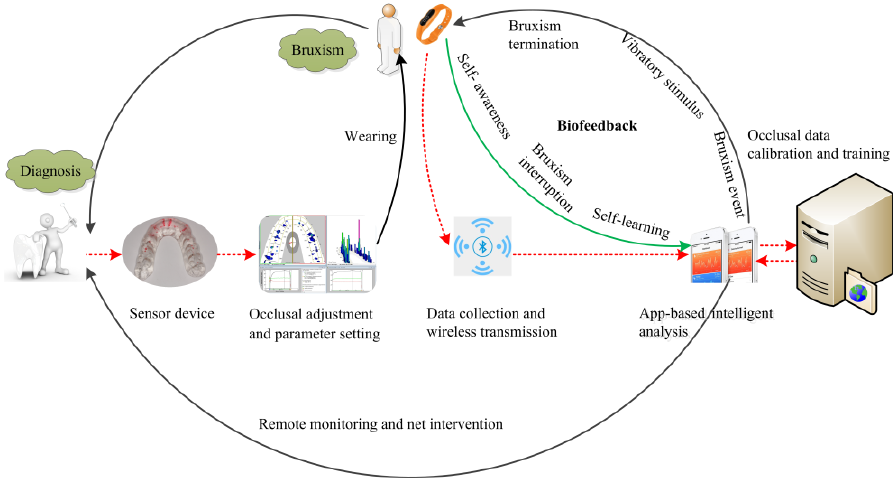
Figure 2. Overall treatment scheme of the biofeedback system we proposed for bruxism.